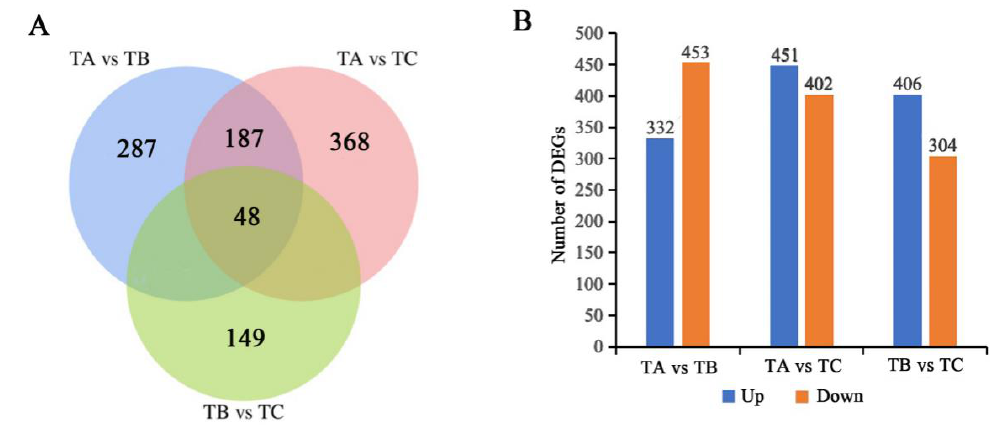
Figure 4. Differentially expressed genes (DEGs) identified in the pairwise comparisons among the three groups (i.e., TA, TB, and TC) of Mortierella alpina ( A ) showing up-regulated and down-regulated DEGs ( B ) .